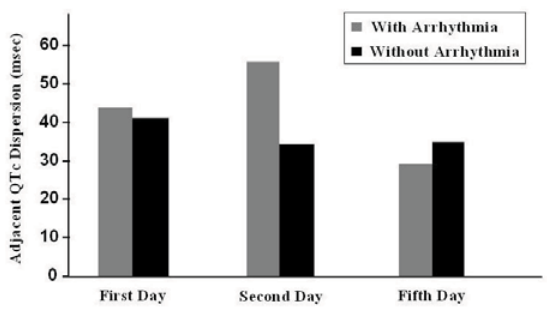
* Non-significant P value